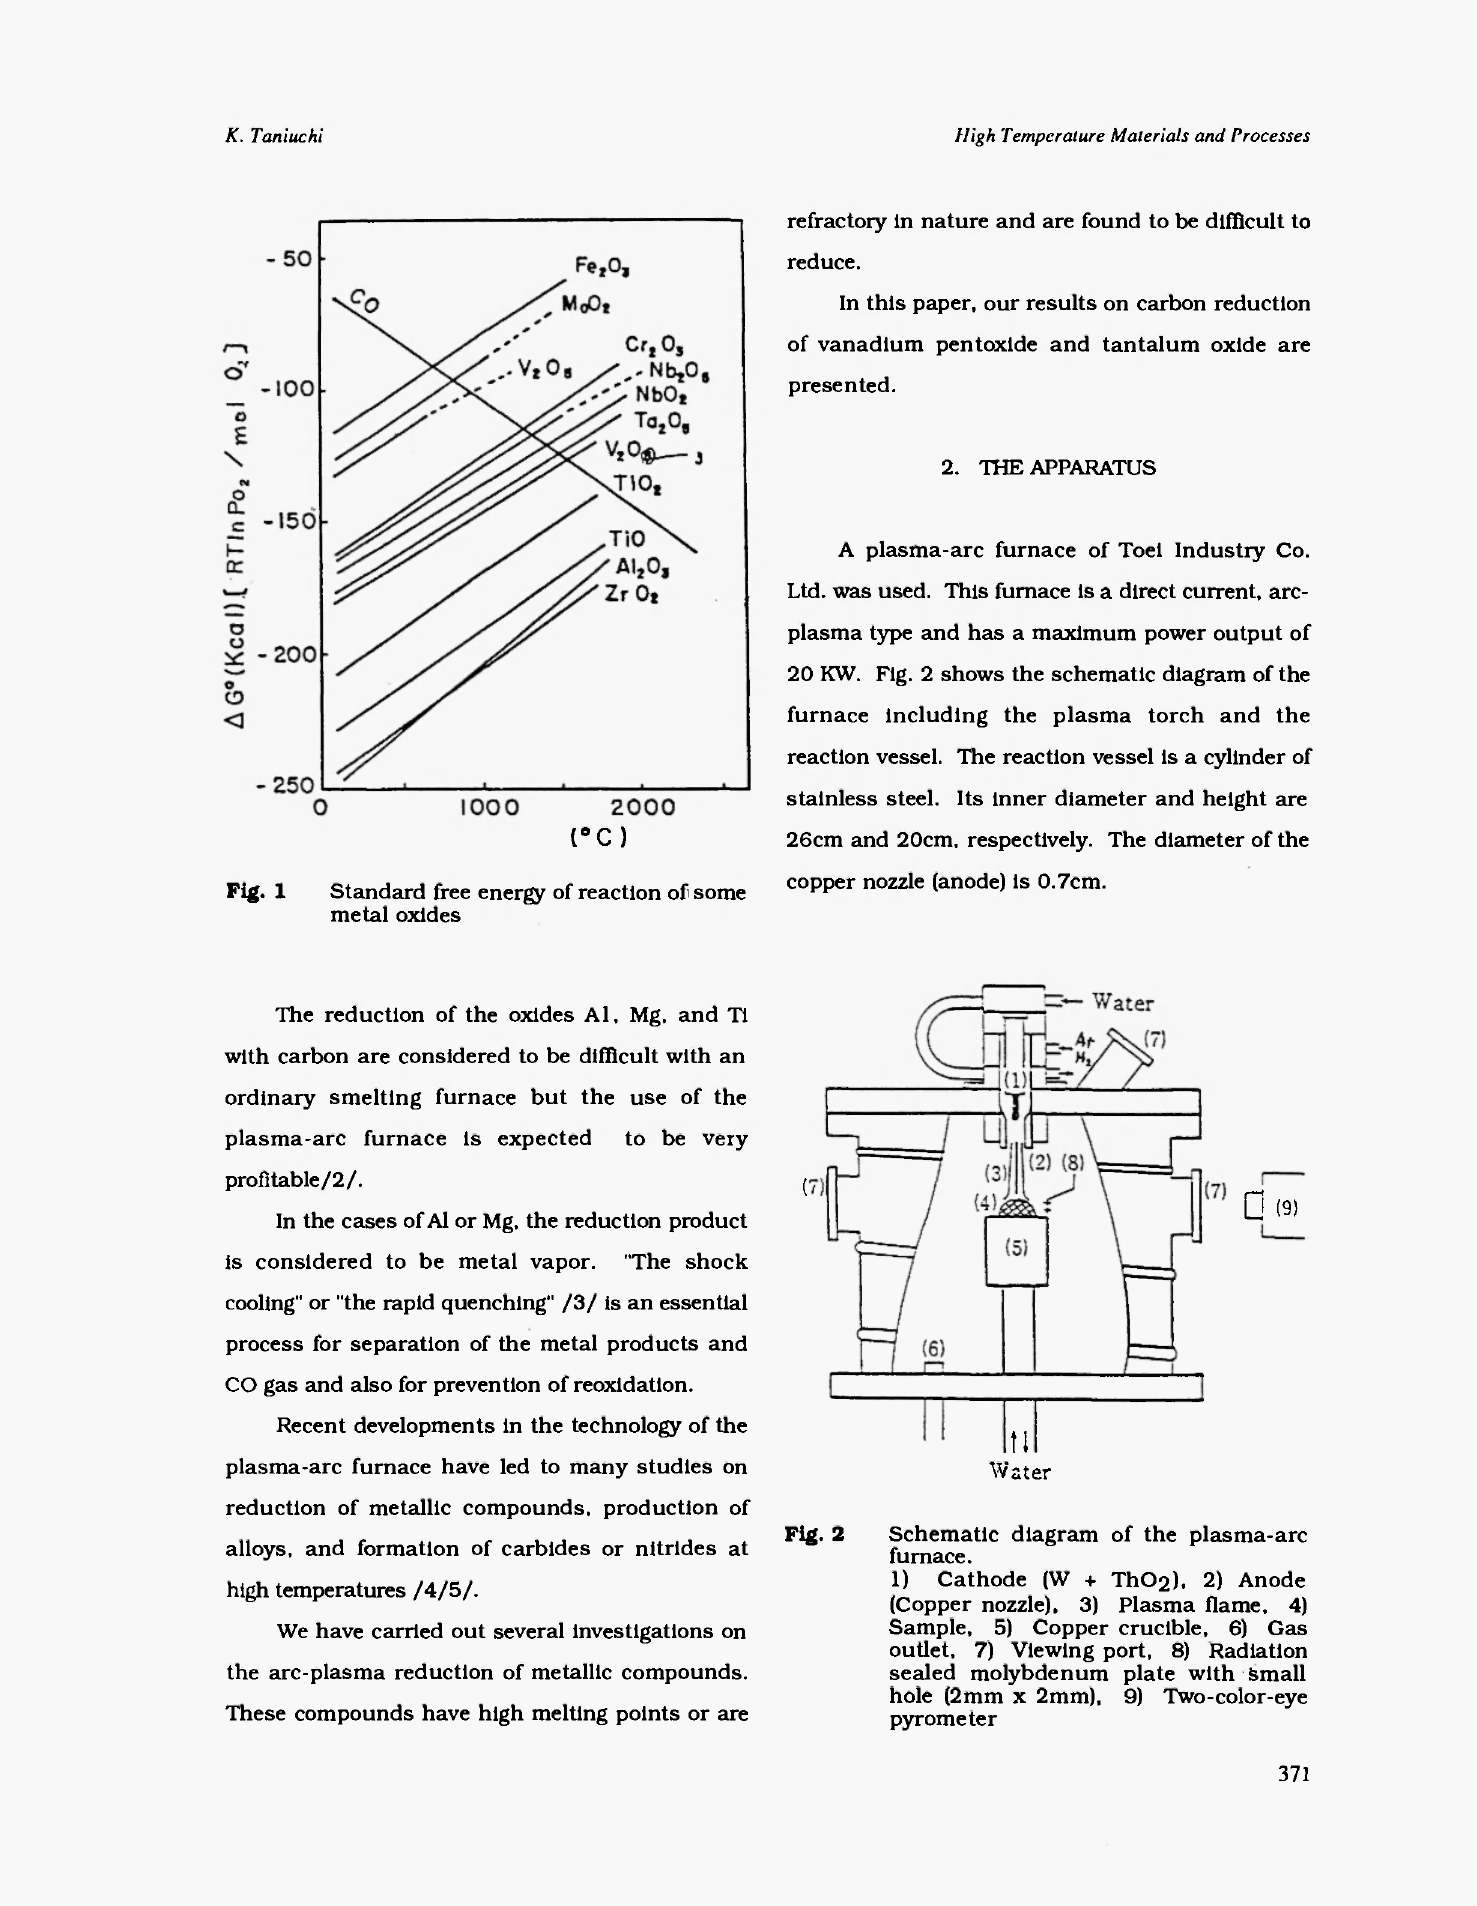
Fig. 1 Standard free energy of reaction of some metal oxides